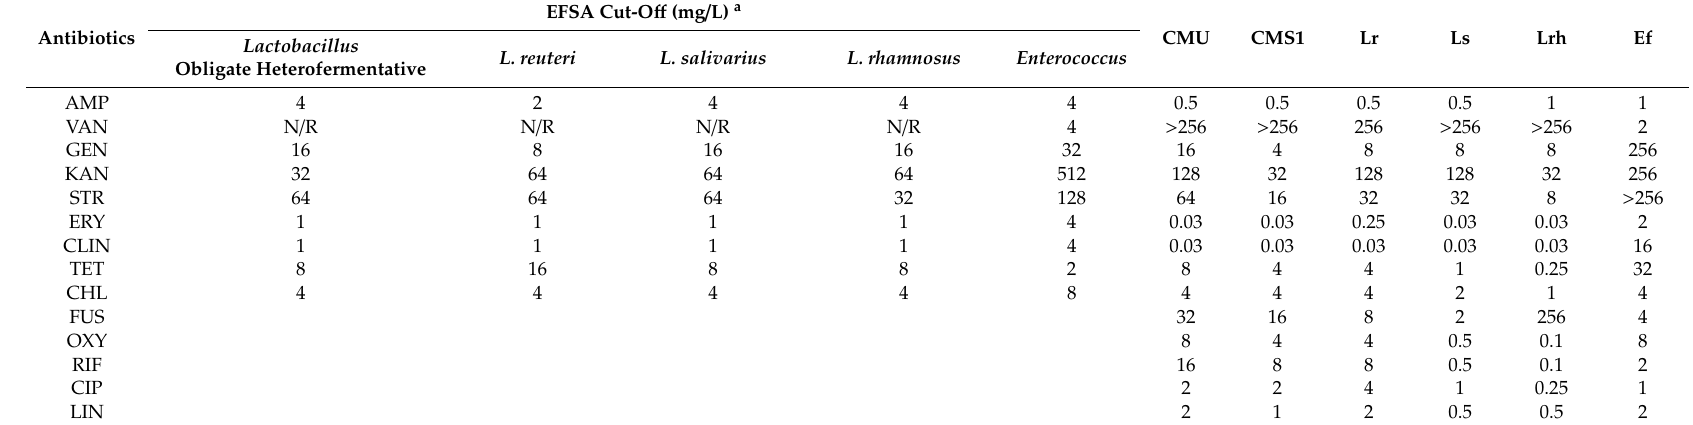
Table 1. Antibiotic resistance profiles and minimum inhibitory concentration (MIC) values of the studied bacterial